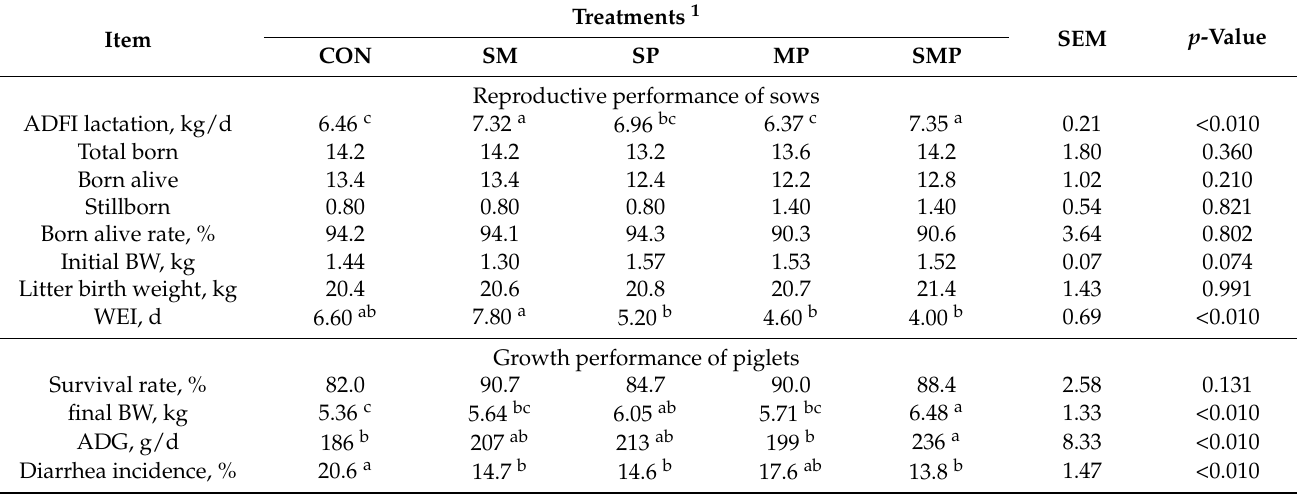
Table 3. Effects of supplementing the diets with different combinations of SB, MCFAs, and omega − 3 PUFA on the reproductive performance of sows and the growth performance of their